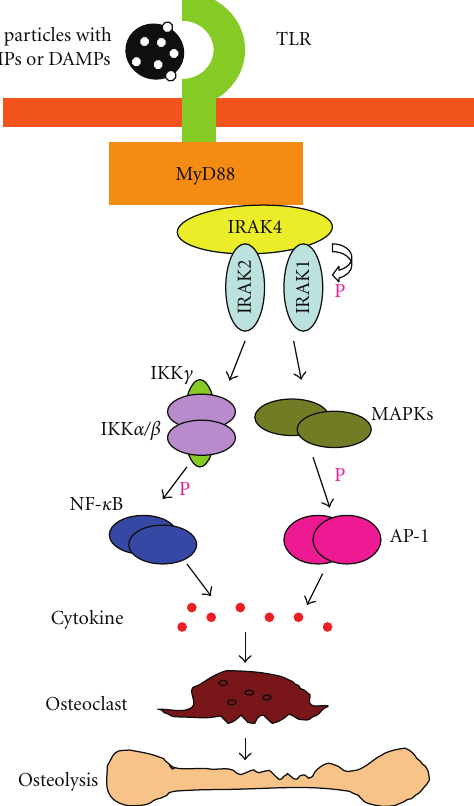
Figure 1: Wear particles induced TLR signal pathway. TLRs rec- ognize wear particles with adherent PAMPs or DAMPs via MyD88. The binding of TLR and MyD88 phosphorylates IRAK4 which in turn phosphorylates IRAK1. The activation of AP-1 and NF- κ B leads inflammatory cytokine production and osteoclast di ff erenti- ation which contribute to